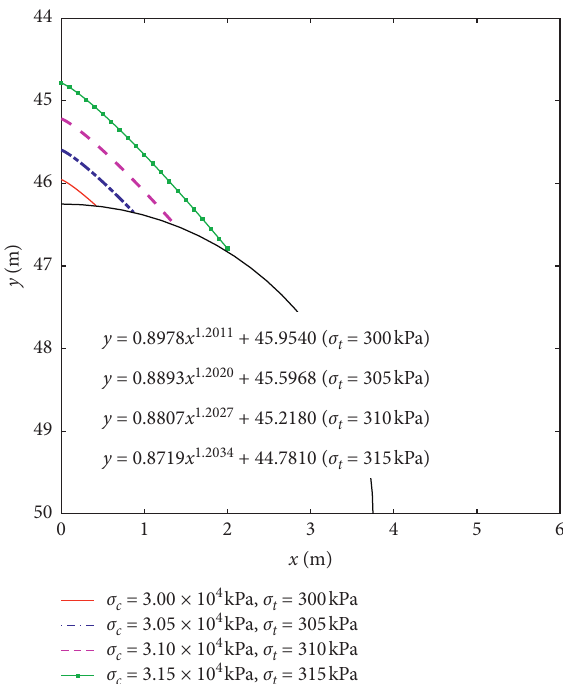
Figure 7: Effect of tensile strength σ on collapse mechanisms. The parameters are A � 0.35, B � 5/6, h − h � 16.68m, r � 3.75m, C � 50m, c w t σ t � σ c /100.